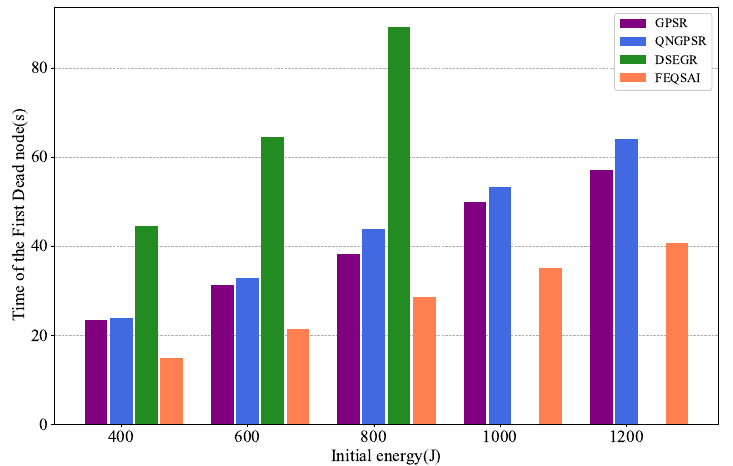
Figure 16. Performance comparison of the time of the first dead node among GPSR, QNGPSR, DSEGR, and FEQSAI with different initial